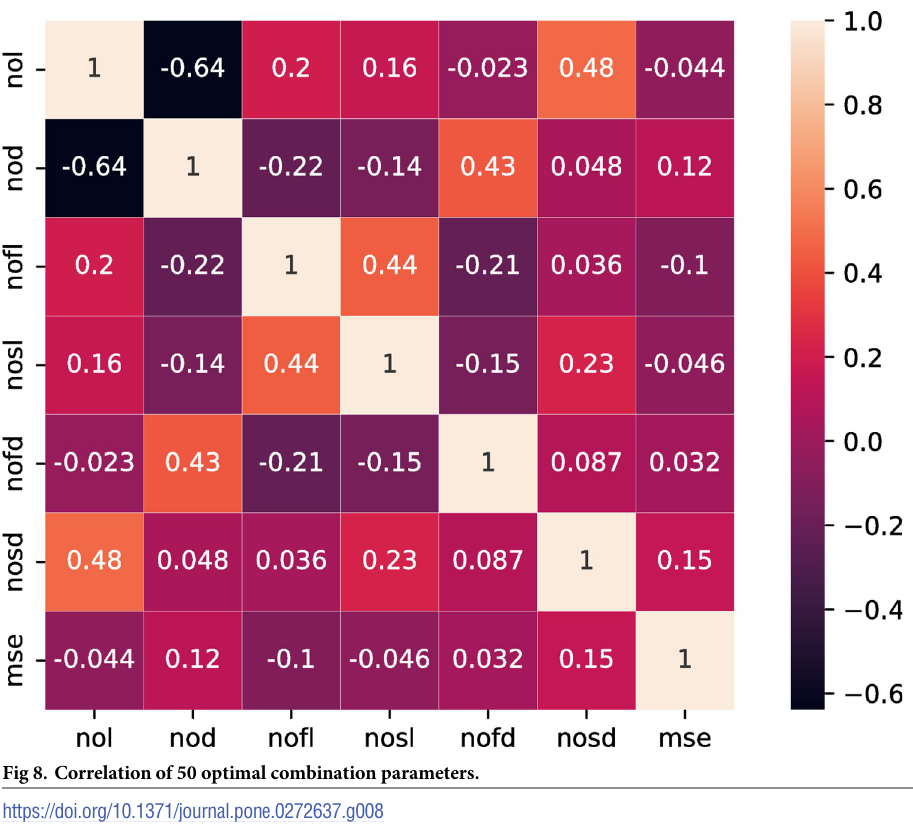
Fig 8. Correlation of 50 optimal combination parameters.